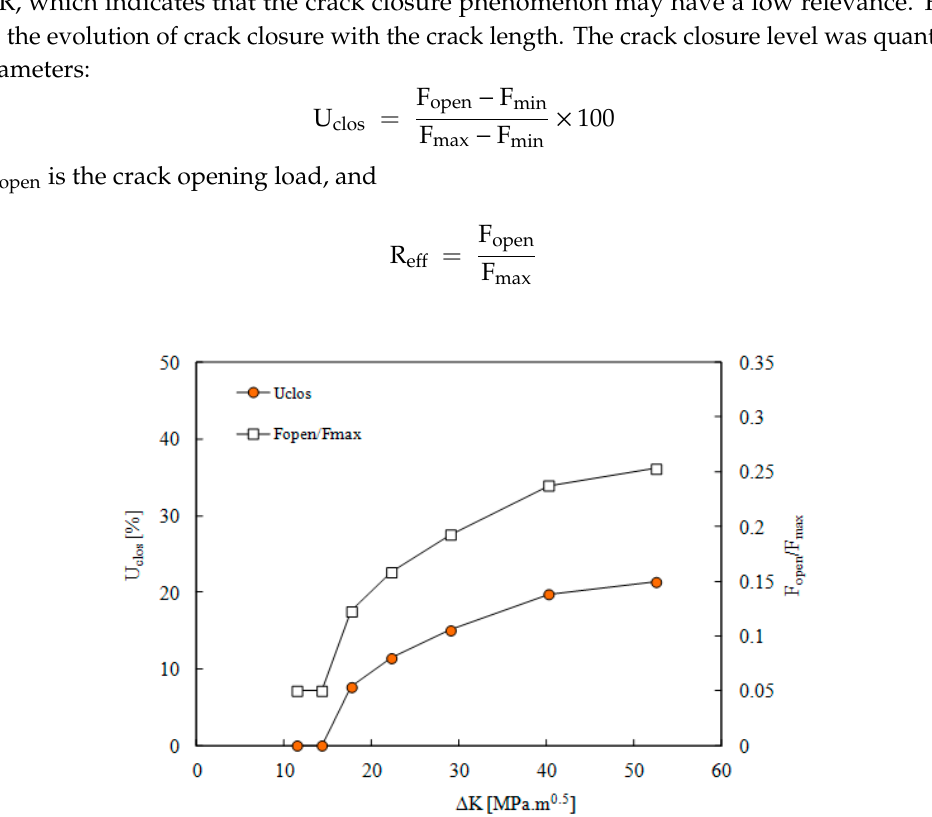
Figure 7. Evolution of plastic CTOD range, δ p , with effective load range (R = 0.01).